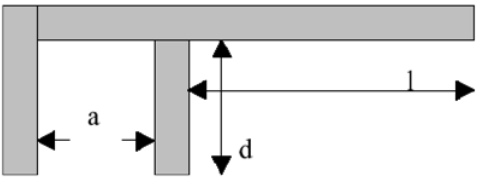
FIGURE 9 Parameters of F-antenna.